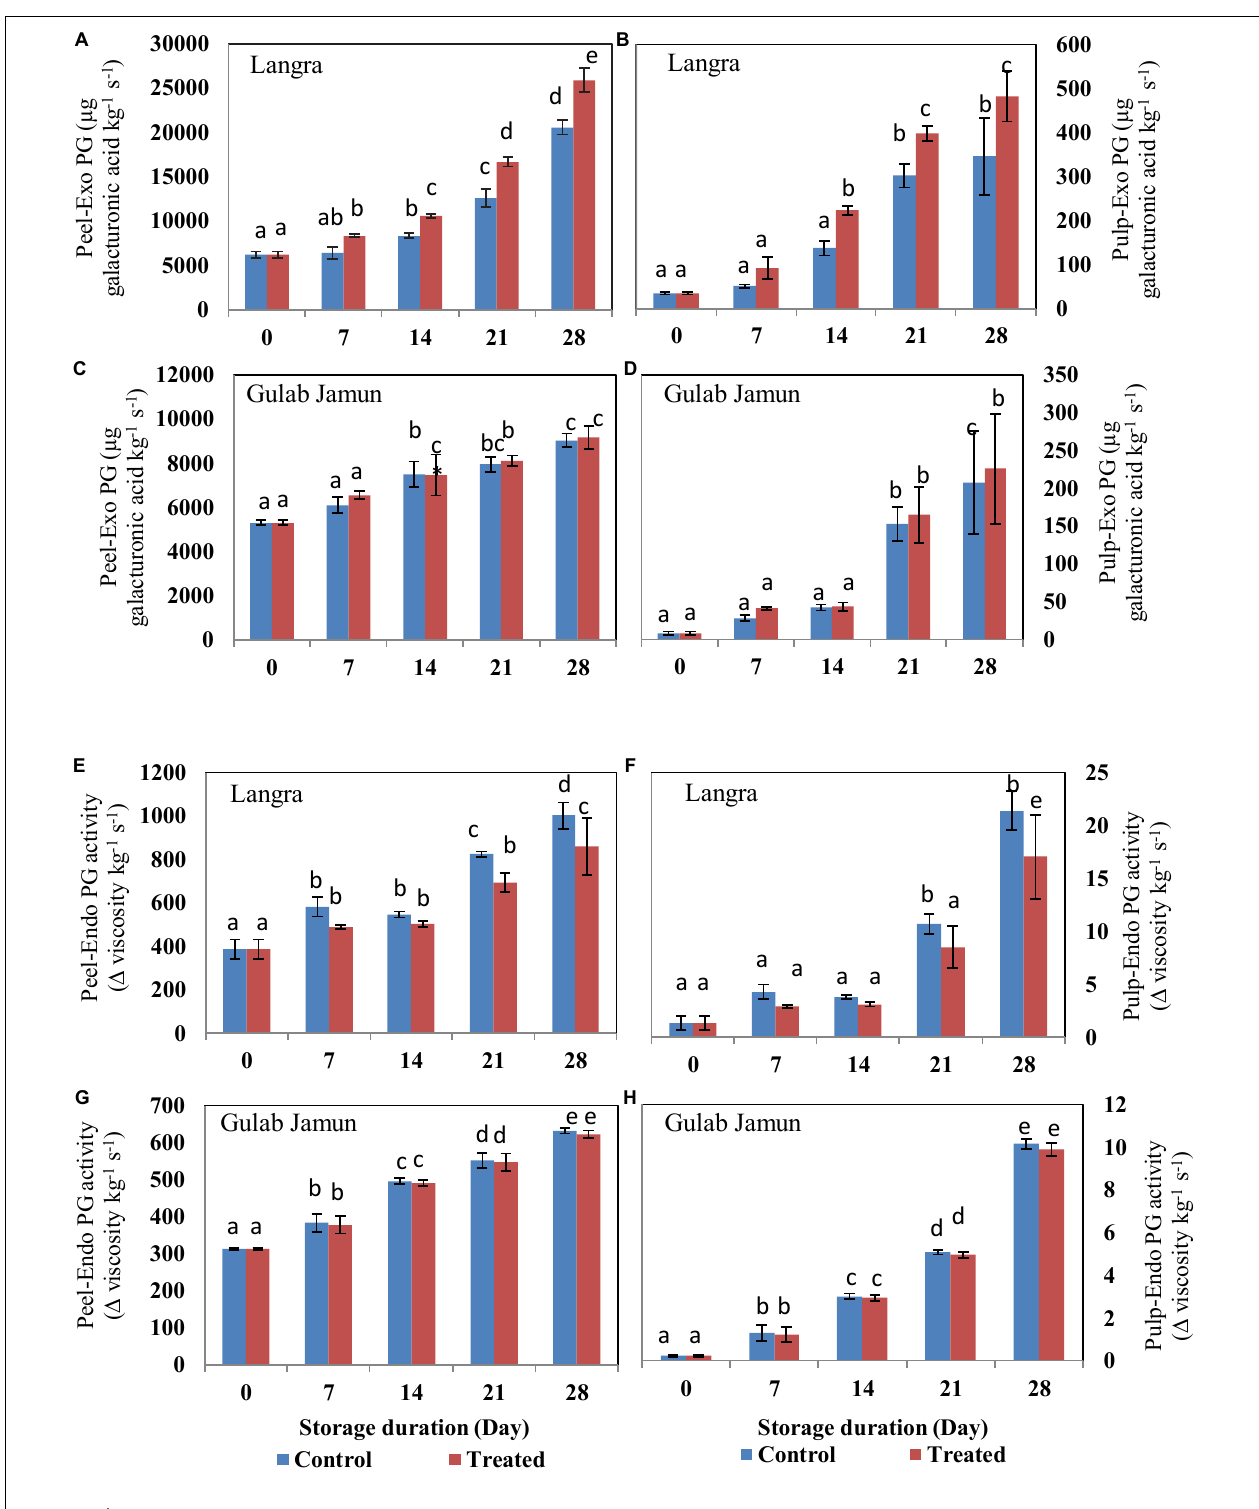
FIGURE 2 | Exo -polygalacturonase ( Exo -PG) activity in (A) ‘Langra’ peel, (B) ‘Langra’ pulp, (C) ‘Gulab Jamun’ peel, and (D) ‘Gulab Jamun’ pulp and endo -polygalacturonase ( Endo -PG) activities in (E) ‘Langra’ peel, (F) ‘Langra’ pulp, (G) ‘Gulab Jamun’ peel, and (H) ‘Gulab Jamun’ pulp treated with 0 µ M (control) or 100 µ M (treated) MT for 2 h, followed by 28 days of storage at 5 ± 1 ◦ C and 3 days of shelf life at room temperature (25 ◦ C, 90–95% RH). Measurements were taken on every 7 days of storage. Each value is the mean of three replicates ± standard error. Error bars with different small letters on the same storage period show a significant difference ( P ≤